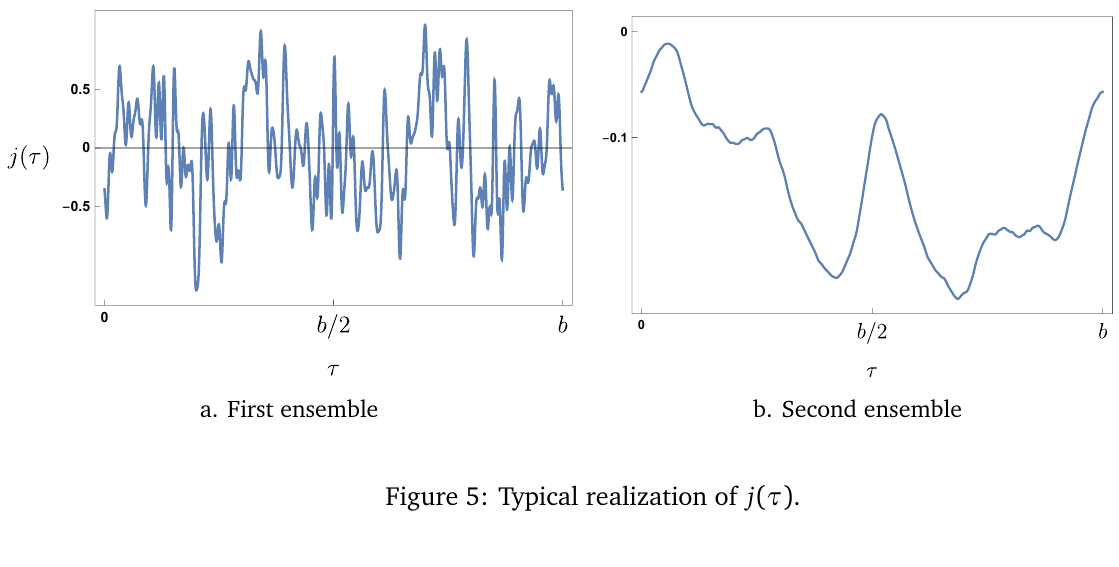
Figure 5: Typical realization of j ( τ )